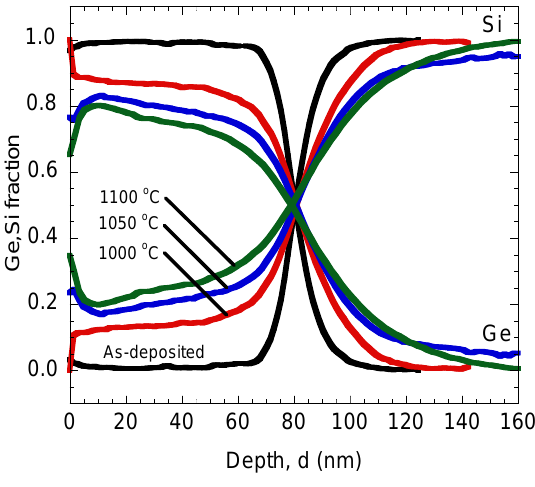
Figure 5. Depth profiles of samples annealed at different